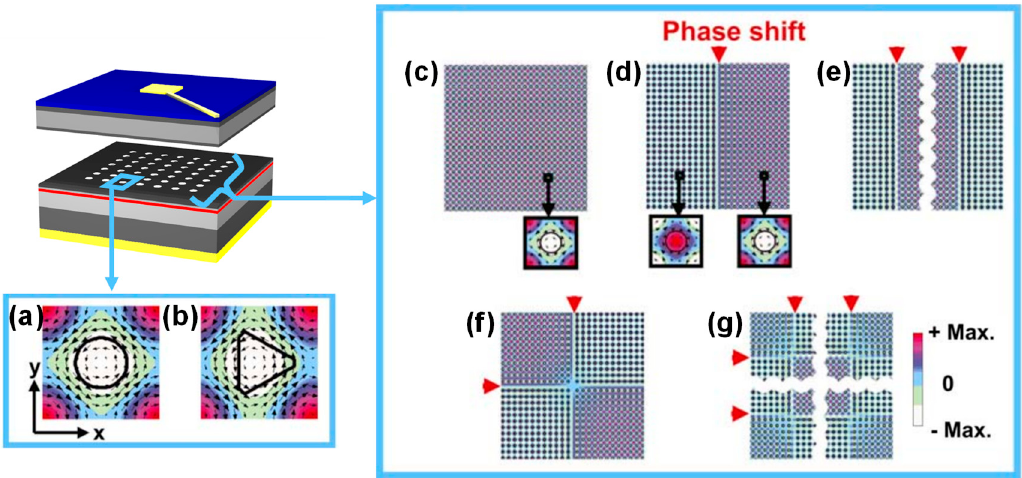
Figure 4. ( a , b ) Electromagnetic field distribution within the unit area for the cases with circular and triangular lattice points, respectively. ( c ) Electromagnetic field distribution in broad area for circular lattice points. ( d – g ) Electromagnetic field distribution when phase shifts are introduced [7].